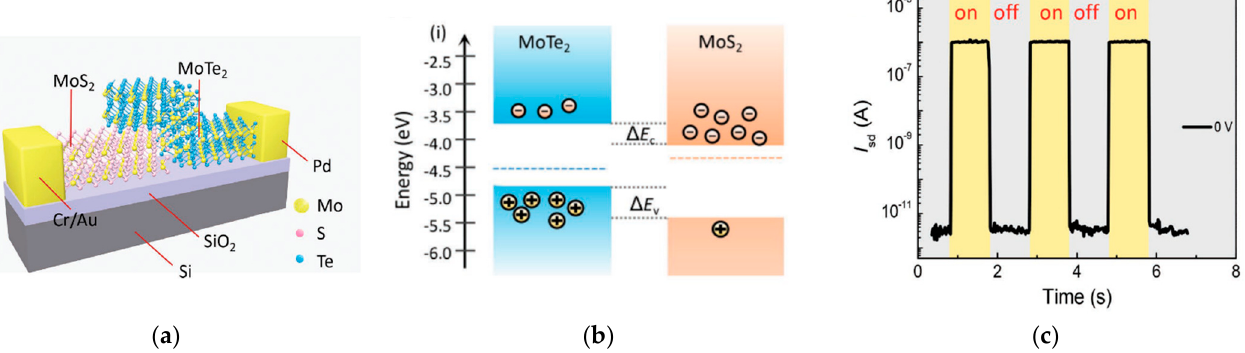
Figure 17. ( a ) Scheme of a photodetector based on an heterojunction between MoS 2 and MoTe 2 . ( b ) Type II band alignment between MoTe 2 and MoS 2 ; ( c ) Photoswitching behaviour of the photodetector at V = 0 V. Reprinted with permission from ref. [36]. © 2018, John Wiley and Sons.